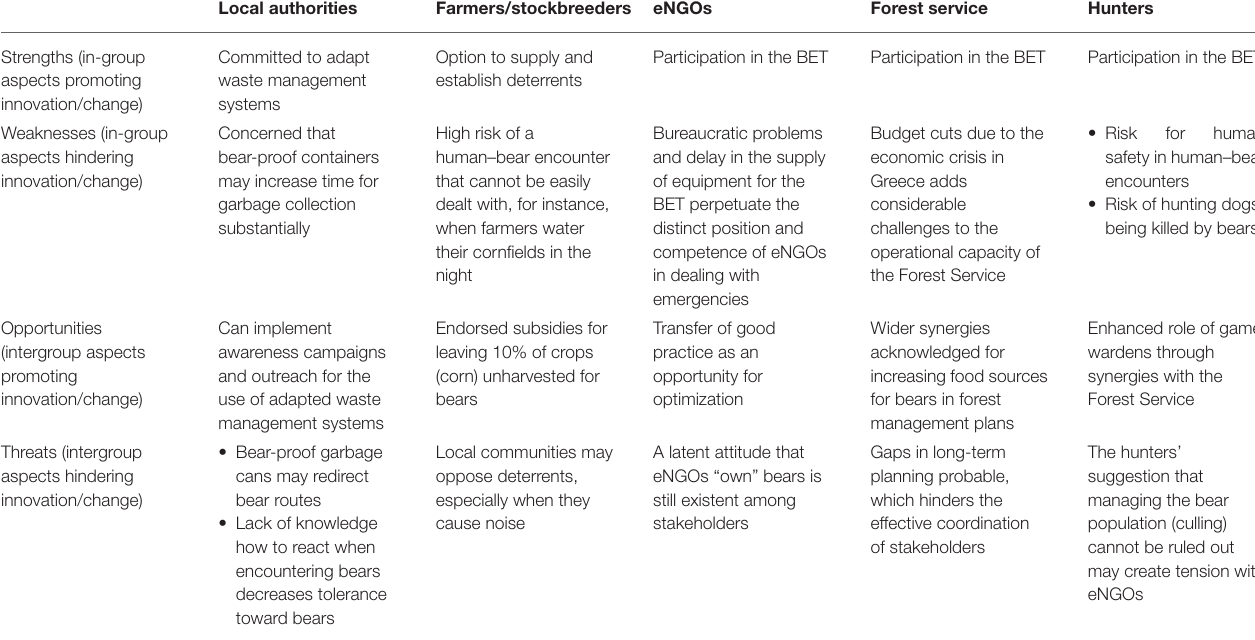
TABLE 1 | SWOT analysis template for bears approaching human settlements.